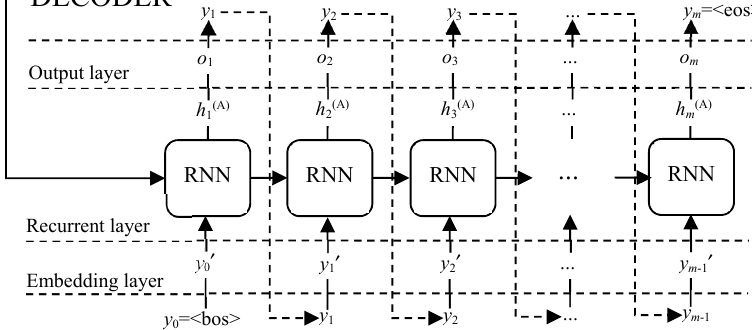
Figure 1. The basic recurrent-based encoder–decoder architecture.